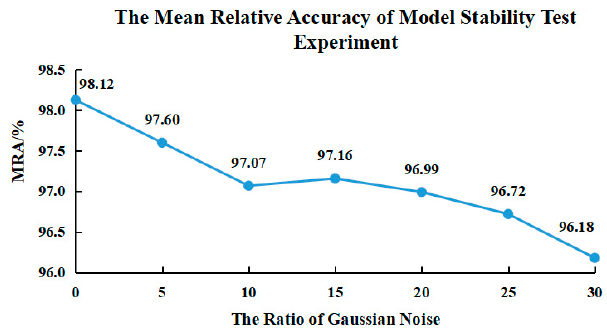
Figure 14. MRA of the results for the model stability evaluation.